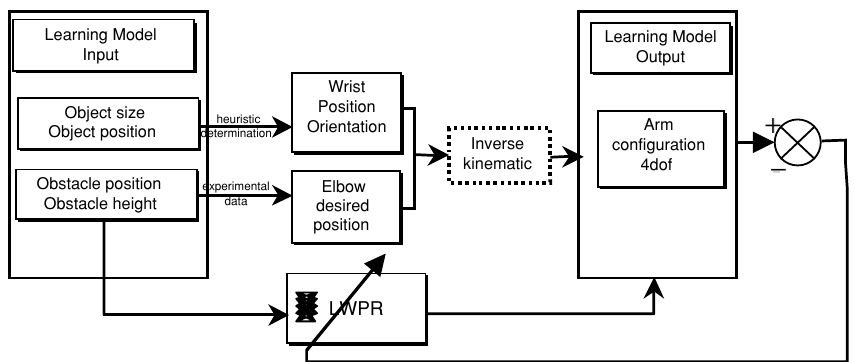
Figure 6 Algorithm for the arm configuration learning. after having specified the obstacle position and size. These mean error values are 5.1 ± 1.0 and 7.2 ± 1.6 mm for the elbow and the wrist, respectively.